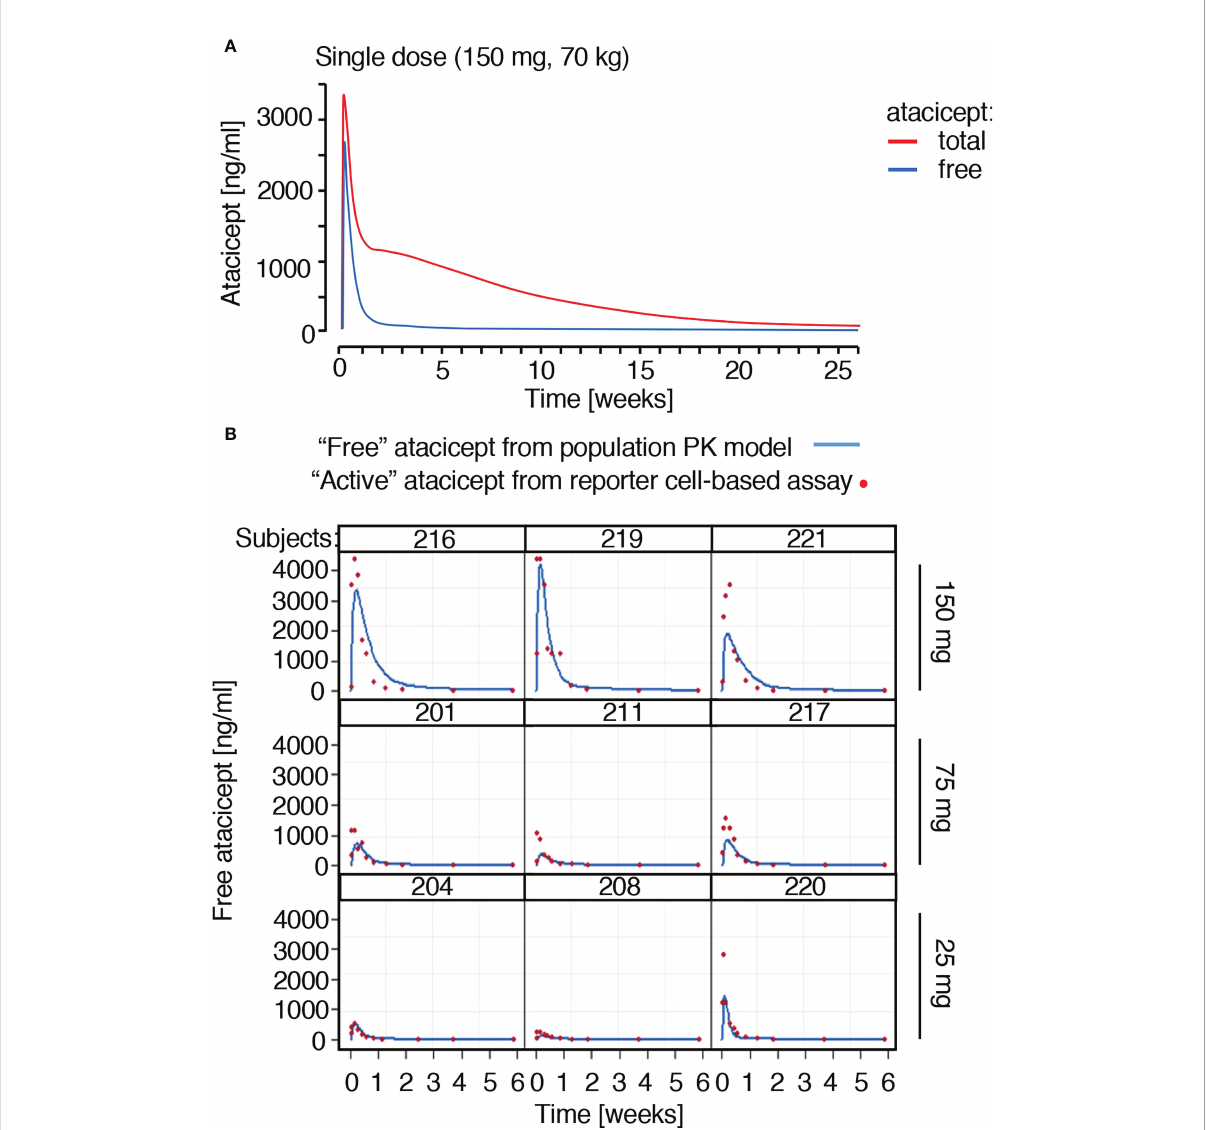
FIGURE 3 Prediction and measures of free or active atacicept in subjects receiving a single atacicept dose. (A) Predicted PK pro fi les for total and free atacicept for a typical 70 kg subject who received a single dose of 150 mg atacicept. Red line: total atacicept. Blue line: free atacicept. (B) “ Active ” atacicept PK pro fi le (red dots) compared with model-derived “ free ” atacicept PK pro fi les (blue line) in nine subjects receiving the indicated doses of